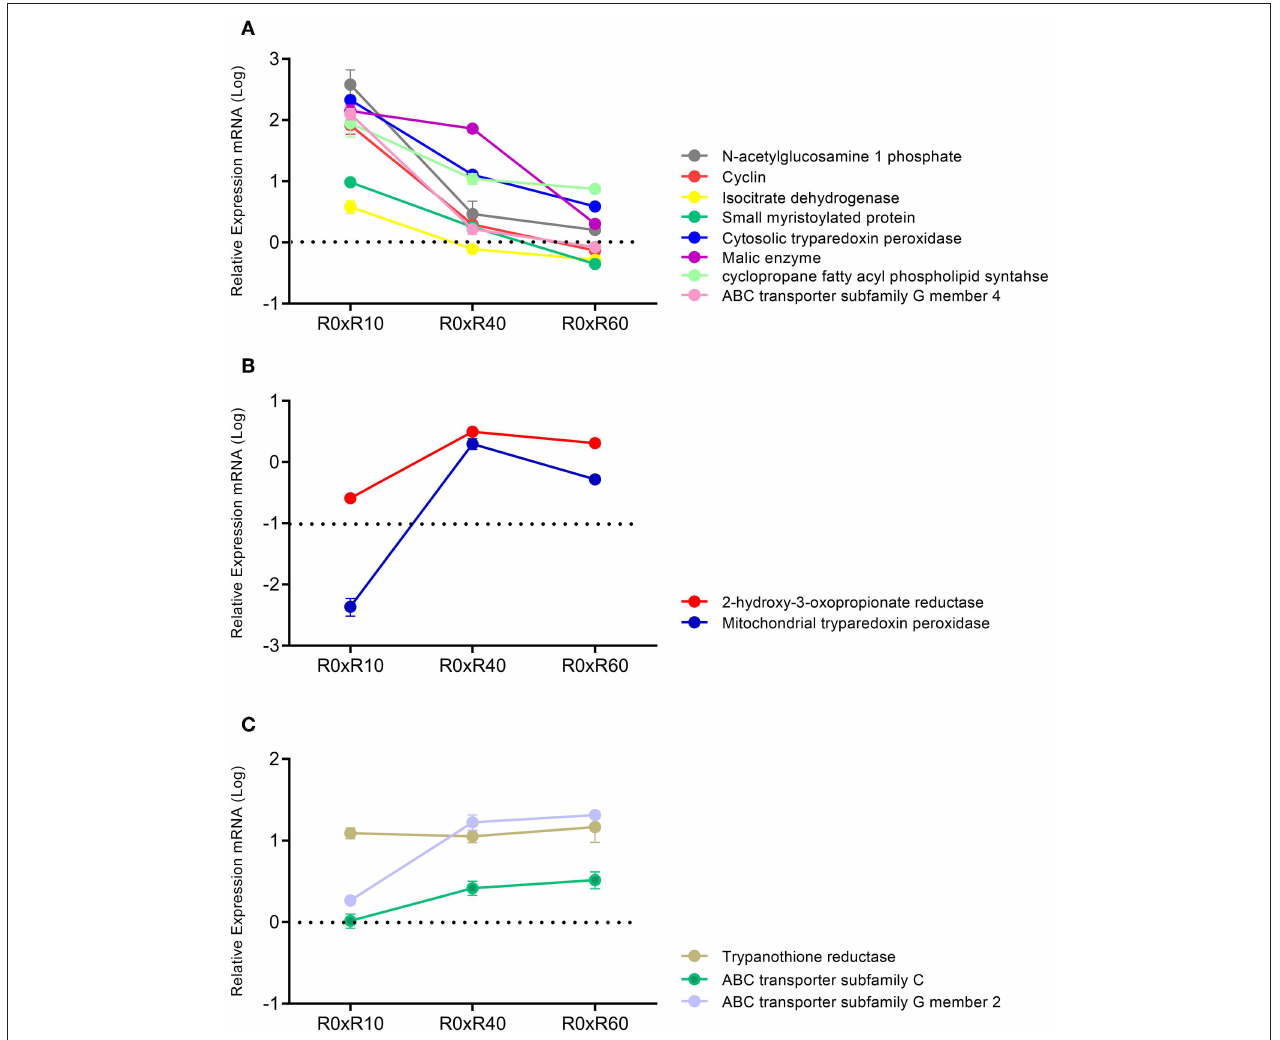
FIGURE 7 | qPCR analysis for expression of 13 genes related to the SIVP process. All measured loci were classified in three clusters, according to its expression. Data represent fold changes for R10, R40, R60, in relation to R0. (A) Cluster 1-N-acetylglucosamine 1 phosphate, Cyclin, Isocitrate dehydrogenase, Small myristoylated protein, Cytosolic tryparedoxin peroxidase, Malic enzyme, Cyclopropane fatty acyl phospholipid synthase, ABC transporter subfamily G member 4. (B) Cluster 2-2-hydroxy-3-oxopropionate reductase, Mitochondrial tryparedoxin peroxidase. (C) Cluster 3-Trypanothione reductase, ABC transporter subfamily C, ABC transporter subfamily G member 2. Samples were analyzed in duplicates, from three different